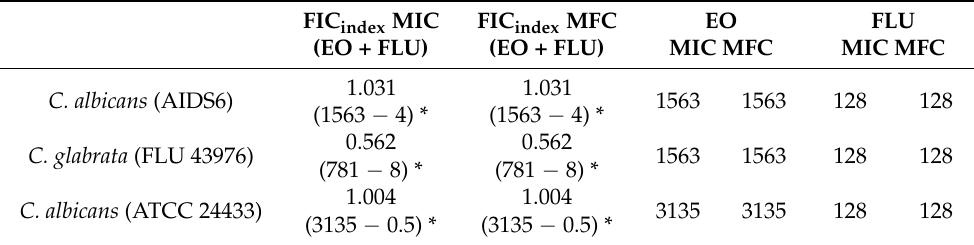
Table 5. Synergistic effect of O. campechianum EO employing fluconazole as synthetic active drug against Candida spp.